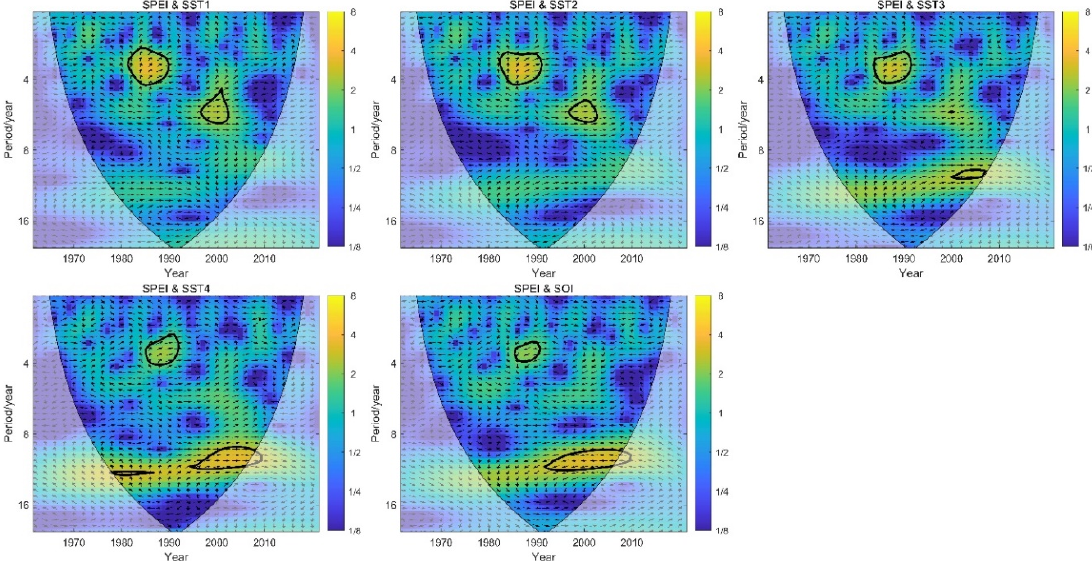
Figure 8. Correlations between the climatic indexes and SPEI on a yearly scale. A bold black contour represents the 95 percent significance threshold against red noise; a thin black line represents the cone of influence (COI) and bold arrows reflect phase